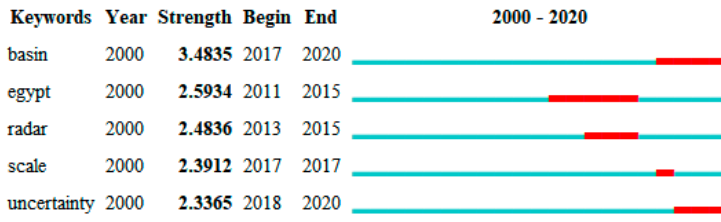
Figure 6. Reference co-citation network for the 248 included articles (clustered according to index terms). The color of each cluster block represents the year when the co-citation relationship first appeared in each cluster. The colors of cluster blocks range from gray to purple, blue, green, yellow, and red, representing the years from 2000 to 2020. The color of each cluster block indicates the year when the co-citation relationship first appeared in each cluster. The connecting line between the nodes indicates the path of the reference. The connecting lines between the nodes indicate the path being cited, and the color of each line indicates the time when it was first cited. A few references are highly co-cited, so here, we set a threshold to show them.